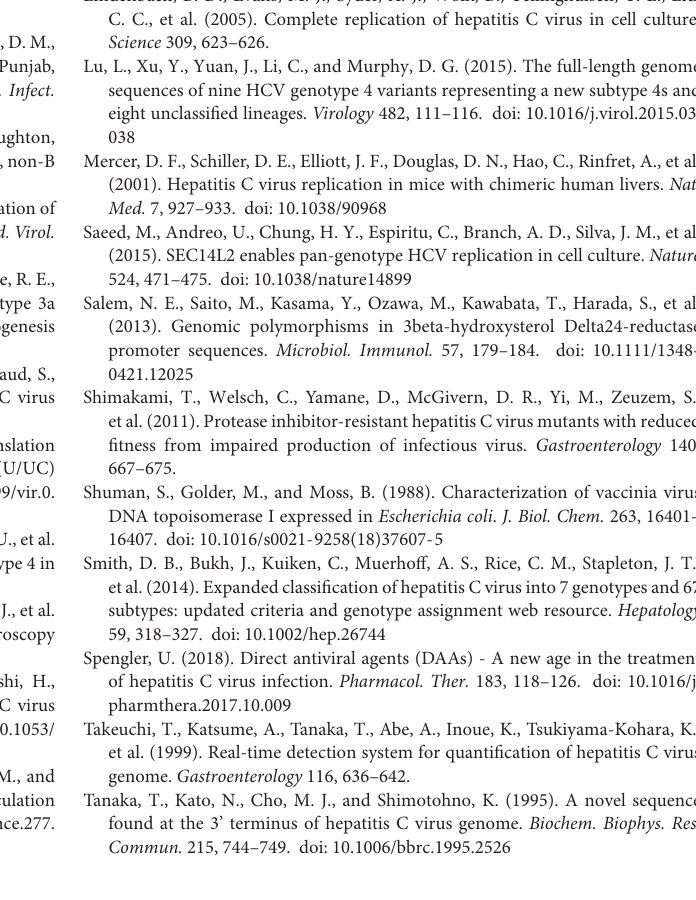
Supplementary Figure 1 | Nucleotide sequence of HCV-G4 KM short clone GenBank: AB795432.1. Supplementary Figure 2 | Nucleotide sequence of HCV-G4 KM long clone GenBank: AB795432.2. Supplementary Figure 3 | (A) Comparison of HCV-G4 KM long and short nucleotide sequences and substituted nucleotides within coding region were shown. Nucleotide substitutions in coding region without amino acid changes are indicated by the red color. Other sequences were all conserved between HCV-G4 KM long and short. (B) Comparison of HCV-G4 KM long and short and nucleotide differences within the 3 (cid:48) UTR were shown. The translation stop codon is indicated with a red square, and positions of U-stretch and 3 (cid:48) X regions are